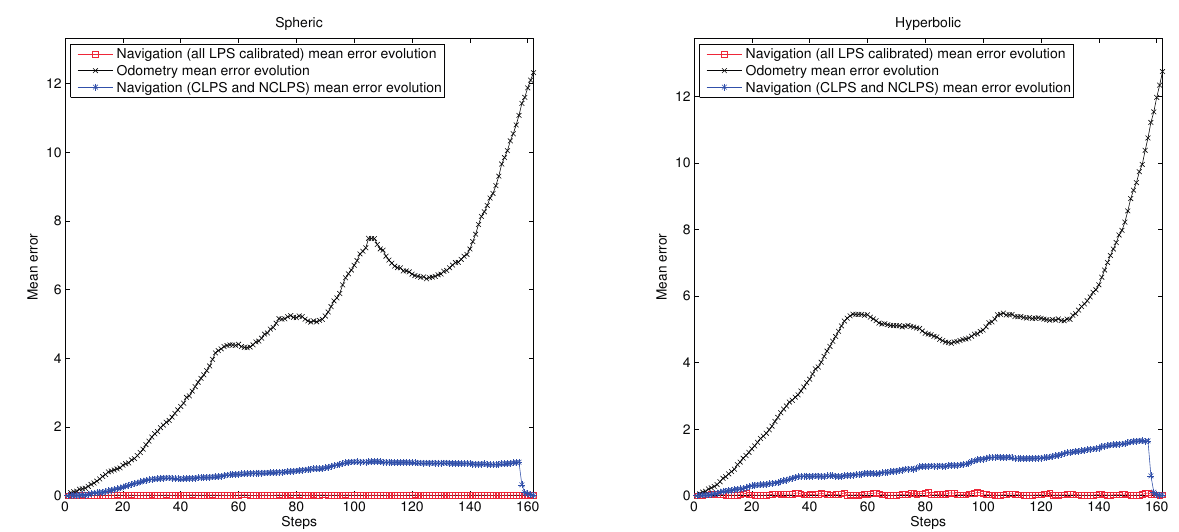
Figure 7. Accumulative mean error evolution for trajectories in Figure 6. ( Left ) Spherical case; ( right ) hyperbolic case.